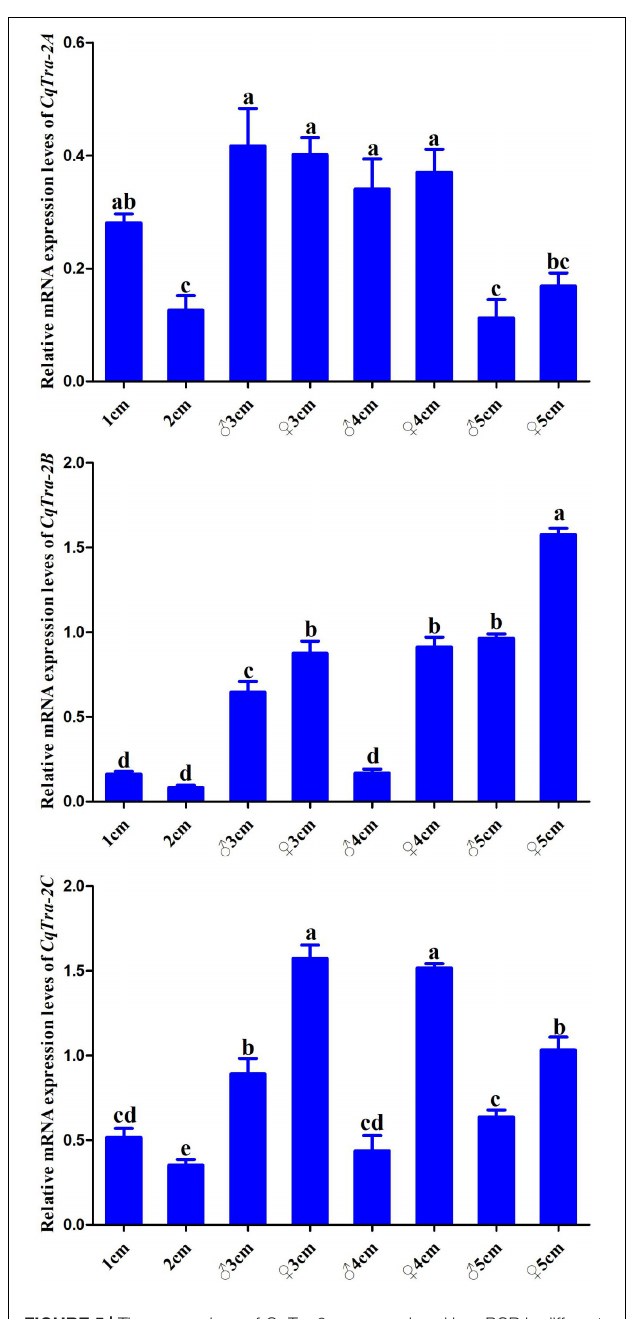
FIGURE 5 | The expressions of CqTra-2 genes analyzed by qPCR in different development stages of C. quadricarinatus . Numbers on the X -axis represent the body length of juveniles. : male. Data are shown as means ± SD. Bars with different letters were considered significant at ♂ p < 0.05.